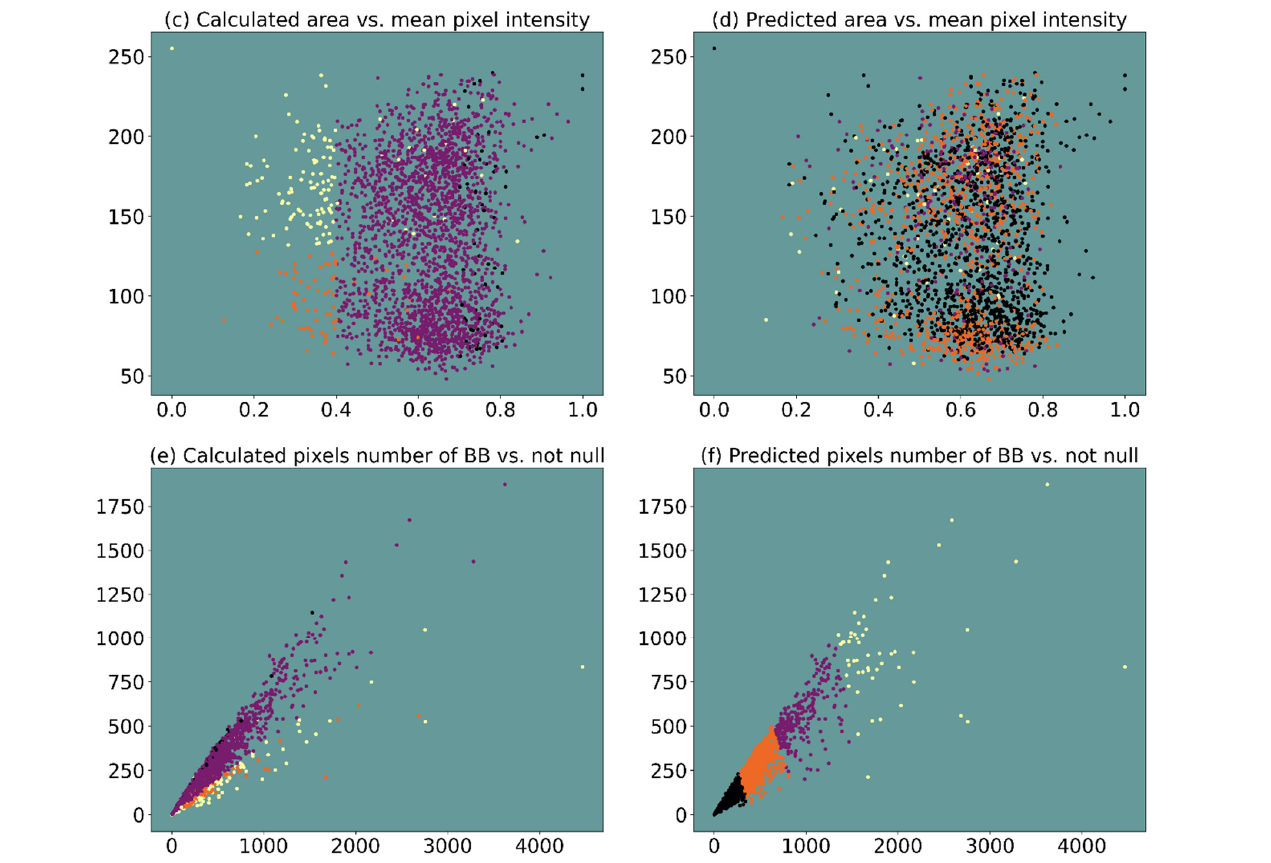
Figure 8. Plotted results of unsupervised classification. The “Calculated” column on the left ( a , c , e ) refers to output data from a human expert, while the “Predicted” column ( b , d , f ) refers to values from unsupervised classification.